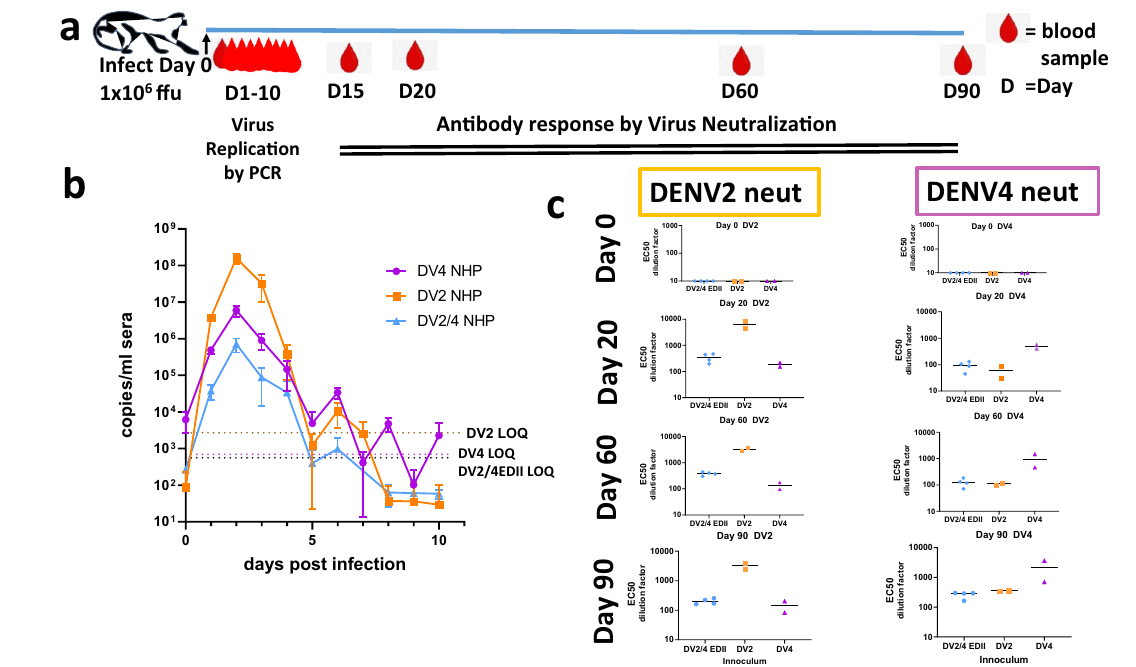
Fig. 4 | DENV2/4EDII chimera replicates ef fi ciently in primates and induces neutralizing antibodies. a Timeline for inoculation of NHP with 10 6 ffu DEN- V2ic(2NHP), DENV4ic(2NHP) or DENV2/4EDIIic(4NHP) and blood collection for quantitative reverse transcript-polymerase chain reaction (qrt-pcr) and FRNT ana- lysis. b ReplicationkineticsofDENV2/4EDIIistemporallysimilartoparentalDENV2 andDENV4.Averagecopies/mlsera,asdeterminedbyqrt-pcr,isshownforDENV2, DENV4 and the four DENV2/4EDII inoculated NHP. Copies/ml was measured